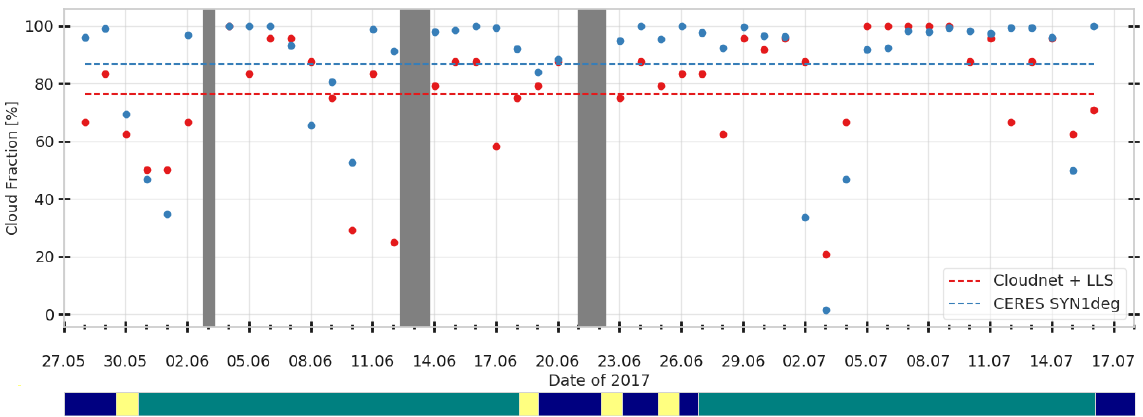
Figure 4. Cloud fraction (CF) observed along the PS106 cruise track. Daily mean CF based on Cloudnet plus detection of low-level stratus (LLS) clouds introduced by Griesche et al. (2020) (red) and CERES SYN1deg (blue). The lower coloured band indicates the times when Polarstern was located in open ocean (blue), the marginal sea-ice zone (yellow) and in mostly sea ice